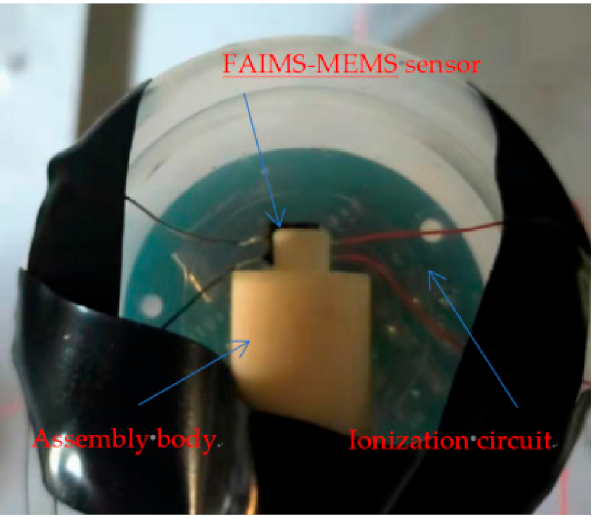
Figure 11. The assembly diagram of the ionization circuit and FAIMS-MEMS